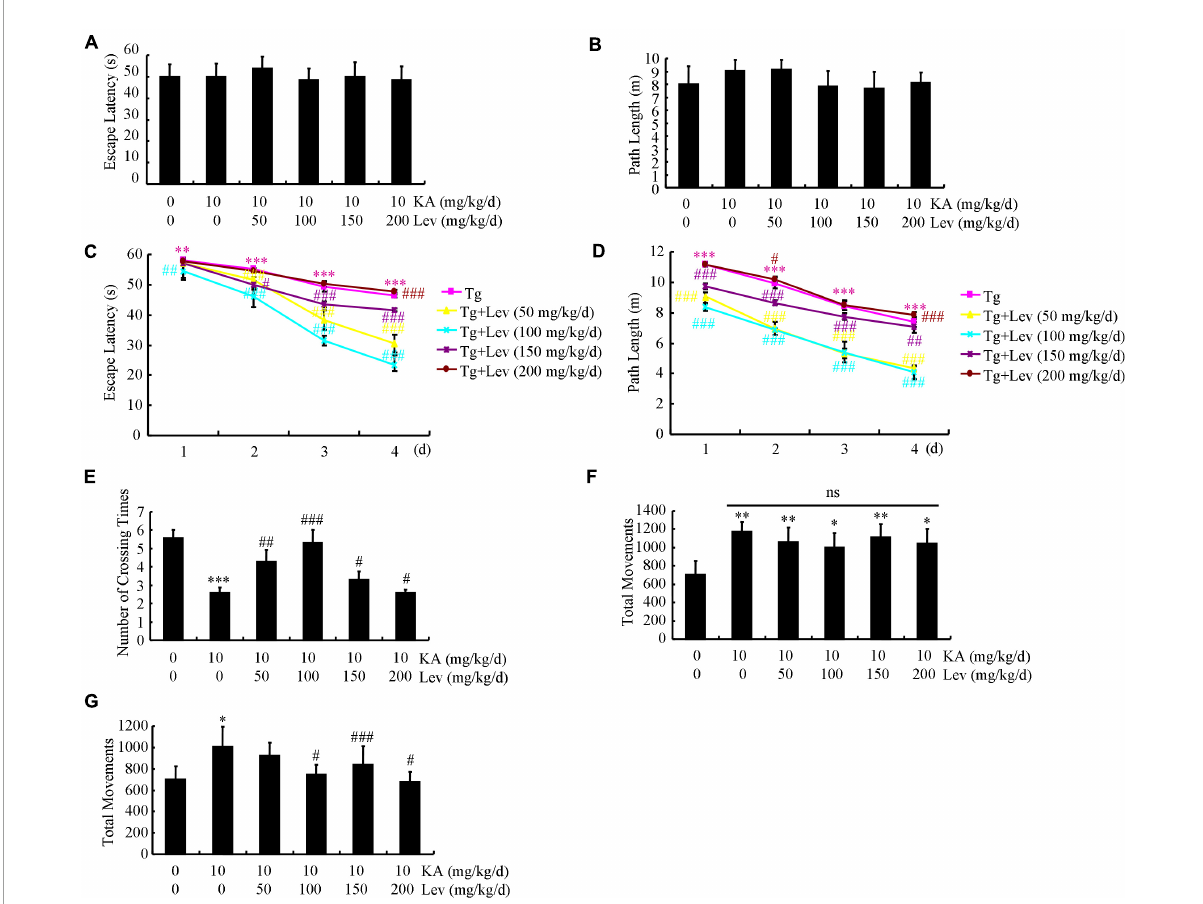
FIGURE1 LEV mitigates KA-induced behavioral abnormalities in APP23/MAPT mice. (A,B) During the first 2 days of visible platform tests, the KA- and LEV-treated and control APP23/MAPT mice exhibit similar latencies in escape time ( P > 0.05, ANOVA). (C,D) In the hidden platform tests, KA-treated APP23/MAPT mice show a longer latency period and travel distance to escape on days 3 and 4; this is ameliorated by treatment with low concentrations of LEV on day 4 (*** P < 0.001 vs. the control group; # P < 0.05; ## P < 0.01; ### P < 0.001 vs. the KA-treated group by ANOVA). (E) In the probe trial on day 7, the KA-treated APP23/MAPT mice travel into the third quadrant (where the hidden platform was previously placed) in significantly shorter times than controls, after treatment with LEV (*** P < 0.001 vs. the control group; # P < 0.05; ## P < 0.01; ### P < 0.001 vs. the KA-treated group by ANOVA). (F,G) Total movements of mice in different groups tested in the open field experiments ( ∗ P < 0.05; ∗∗ P < 0.01; ∗∗∗ P < 0.001 vs. the control group; # P < 0.05; ### P < 0.001 vs. the KA-treated group by ANOVA) KA, kainic acid; LEV,